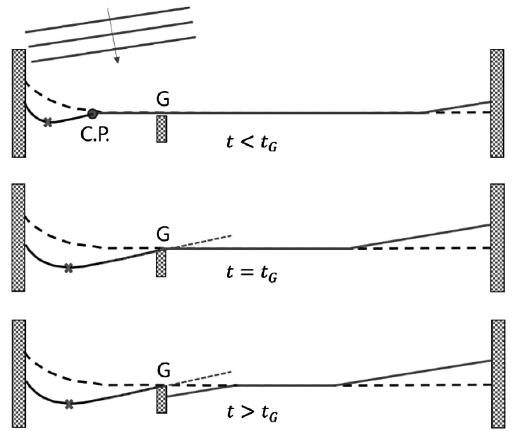
Figure 20. Controlling maximum erosion width by installing a short groin at point